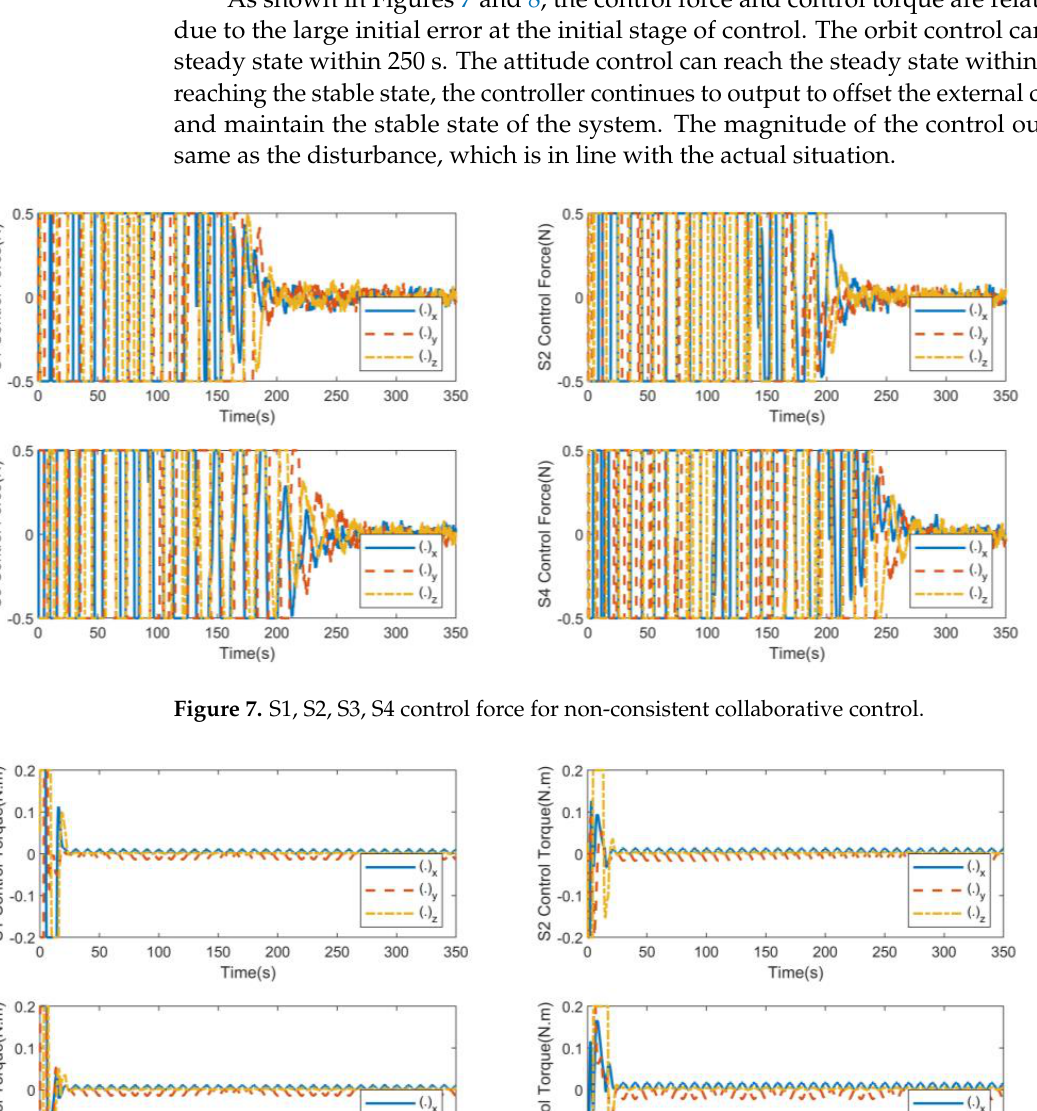
Figure 6. Angular velocity errors for non-consistent collaborative control: ( a ) S1 angular velocity errors and S2 angular velocity errors; ( b ) S3 angular velocity errors and S4 angular velocity errors.